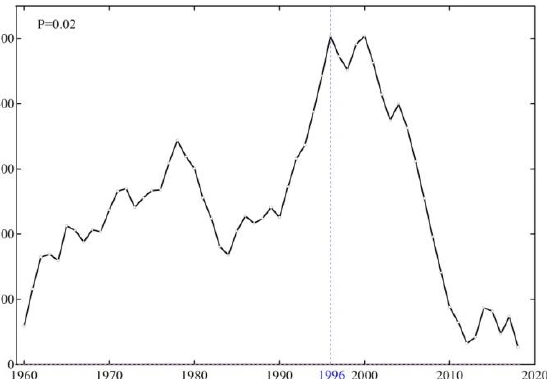
Figure 5. Abrupt changes based on the Pettitt test about the scPDSI in the whole Mongolian Plateau from 1959 to 2018.